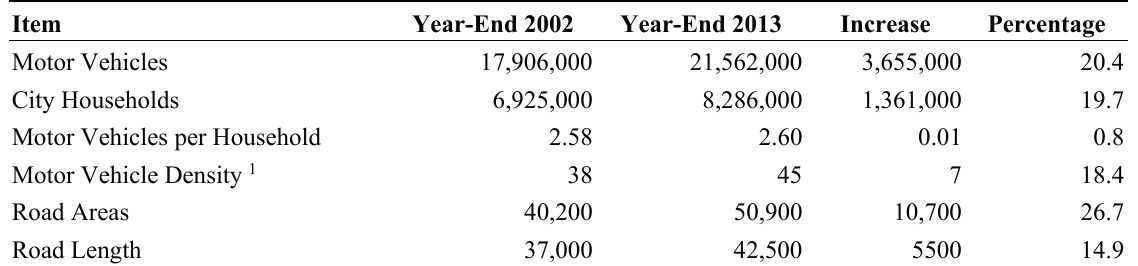
Table 2. Road construction and motor vehicles development in Taiwan’s cities from 2002 to 2013.